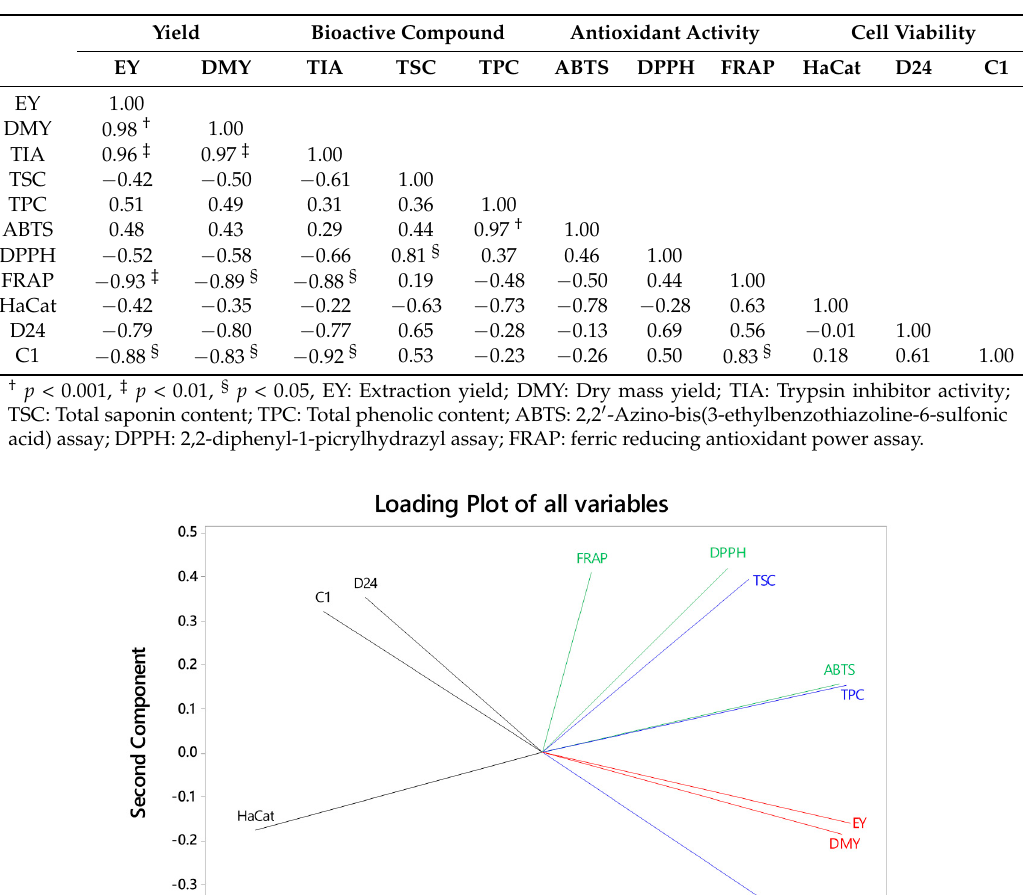
Table 3. Coefficient of correlations ( r ) between yields, bioactive compounds, antioxidant activity, and cell viability across the Gac seed crude extracts.